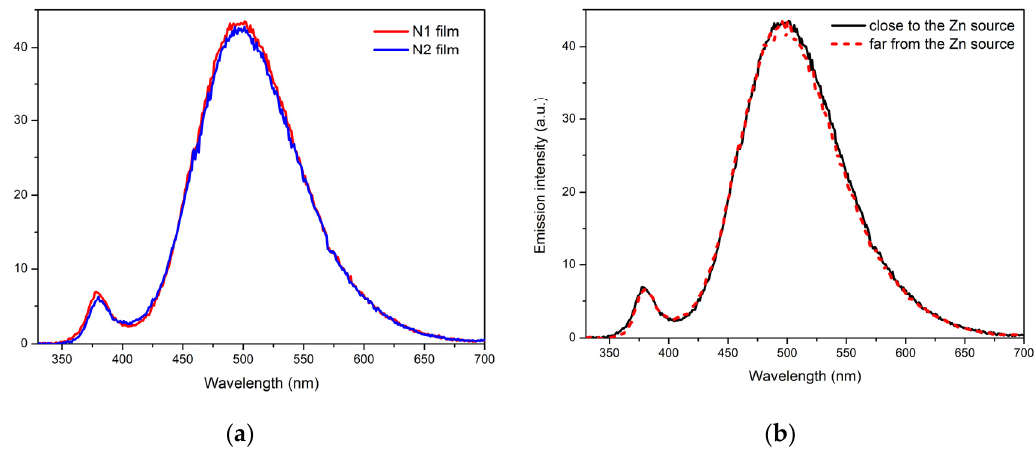
Figure 7. PL spectra of the front surfaces of the films under low-intensity excitation: ( a ) N1 (red) and N2 (blue) films. ( b ) Two opposite parts of the N1 film located at different distances from the Zn vapor source during the ZnO synthesis. The black solid (red dashed) line is for the sample’s area closest to (farthest from) the Zn source.